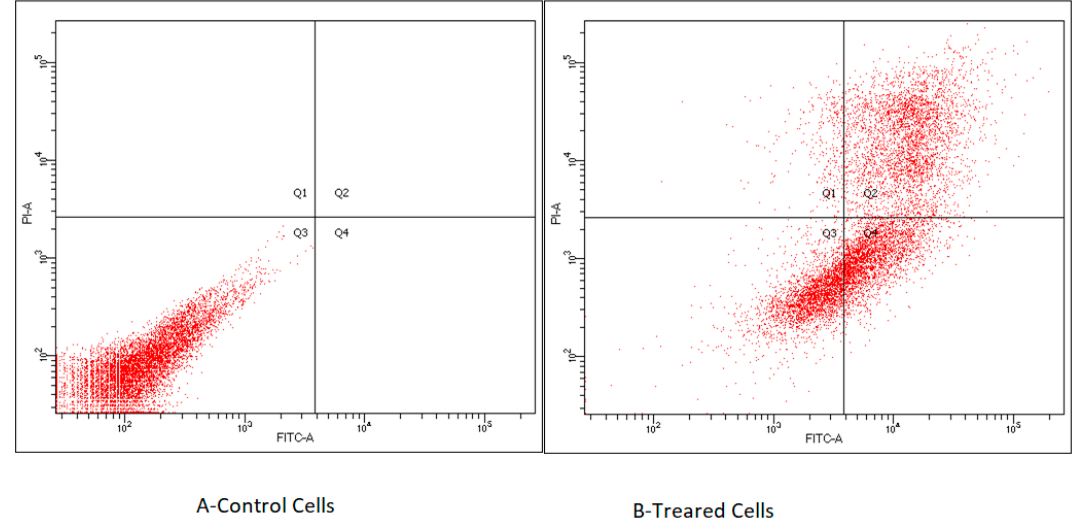
Figure 9. ILs induce apoptosis in T47D breast cancer cells. ( a ) Control cells, ( b ) T47D cells treated with 300µM of 22 for 48 h.